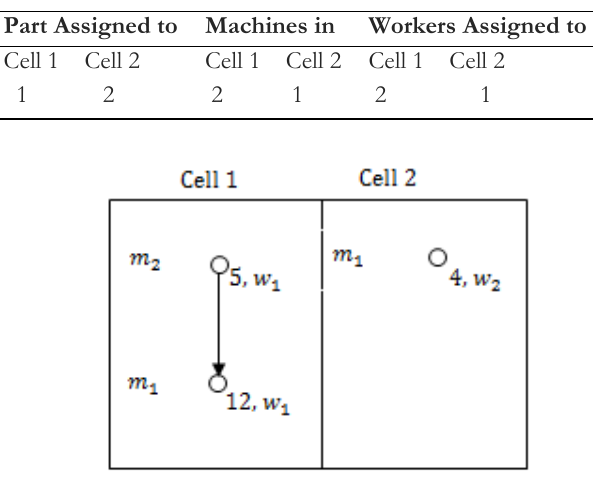
Fig. 2. Network graph